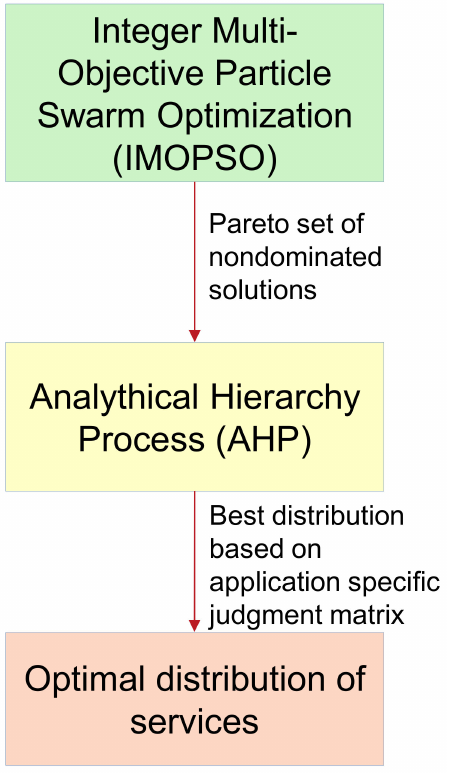
Figure 4. Flow chart of the proposed service distribution optimization